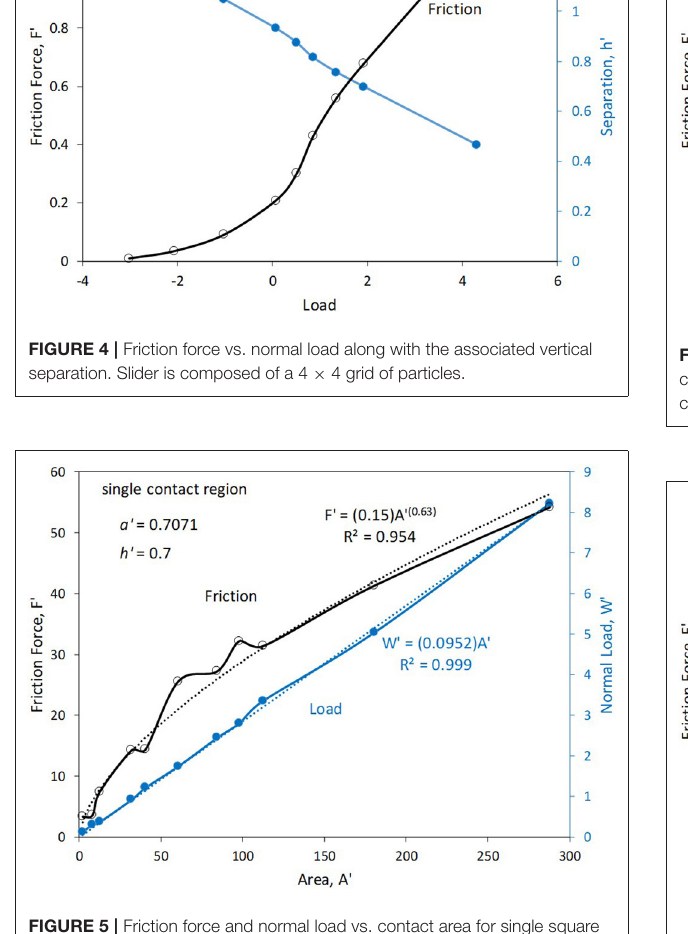
FIGURE 7 | Friction force vs. contact area for long and wide